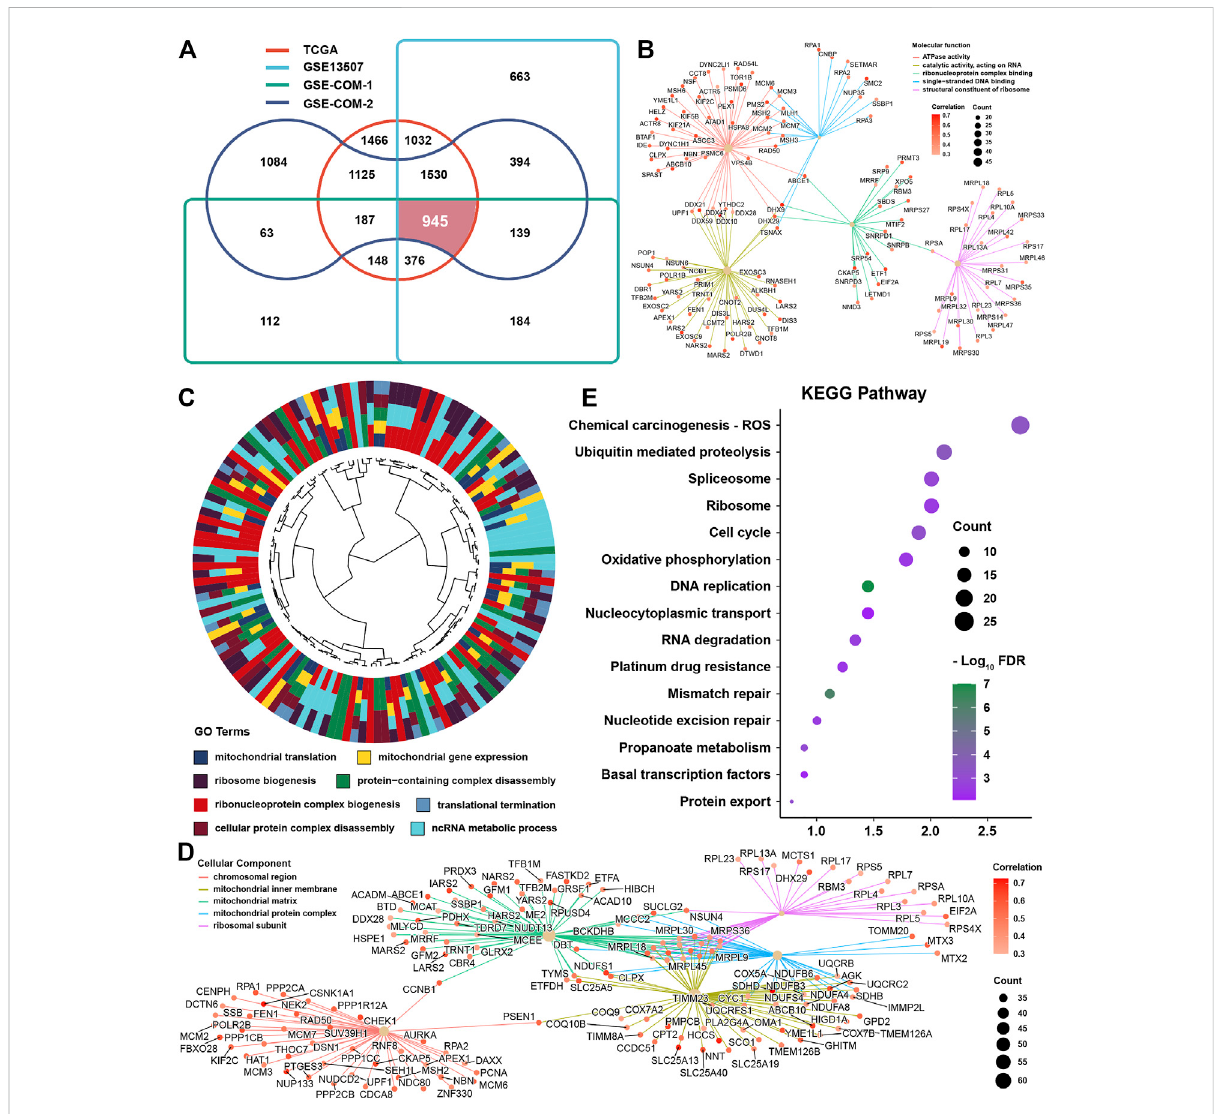
FIGURE 4 Identi fi cationandfunctionpredictionofcuproptosis-relatedgenes (A) Intersectionresultsfromfourdatasetsforcuproptosis-relatedgenes (B)